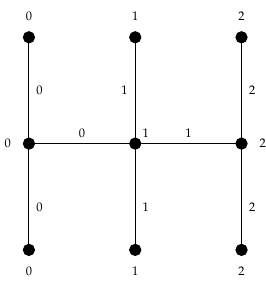
Figure 10. 3-TEMC labeling of DCO 3